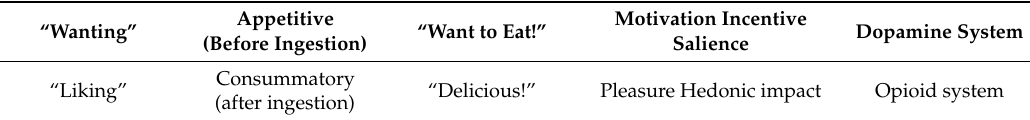
Table 1. Simplified comparison of “wanting” vs.